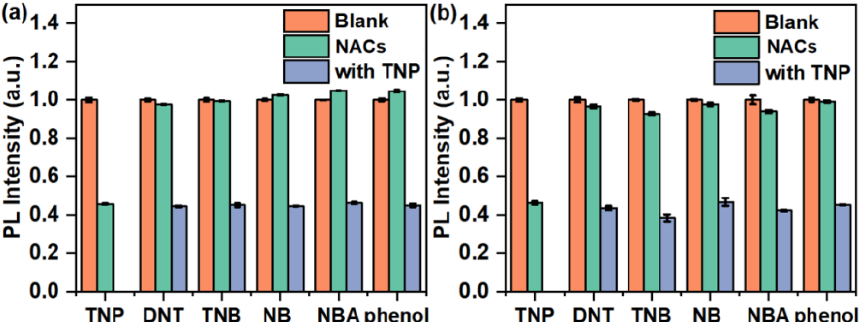
Figure 6. The quenching degree of l -PAnTPE ( a ) and PAnTPE ( b ) aqueous dispersion towards different nitroaromatics (NACs) and phenol of 70 µ M and 35 µ M, respectively, followed by adding the same amount of TNP.